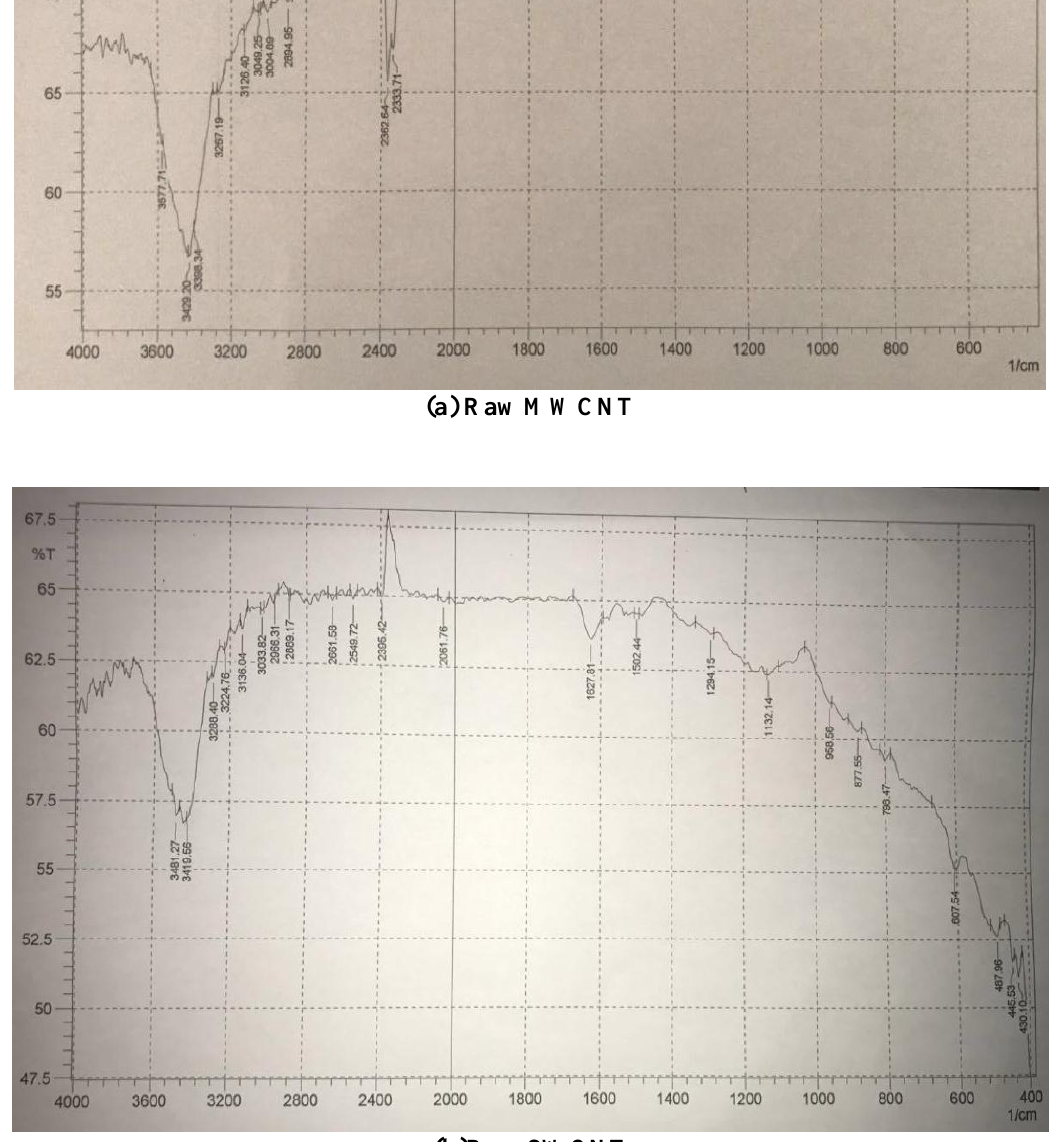
Fig.3: (a) Raw-MWCNTs and (b) raw-SWCNTs FTIR